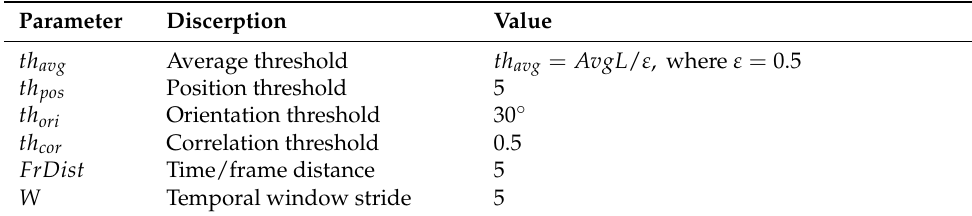
Table 2. Experimental parameter settings for the HTA